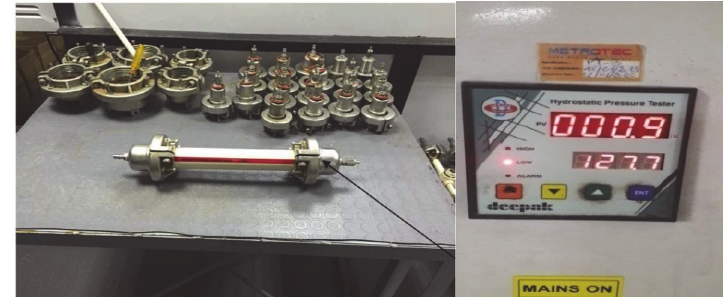
Figure 4: Equipment of the test.